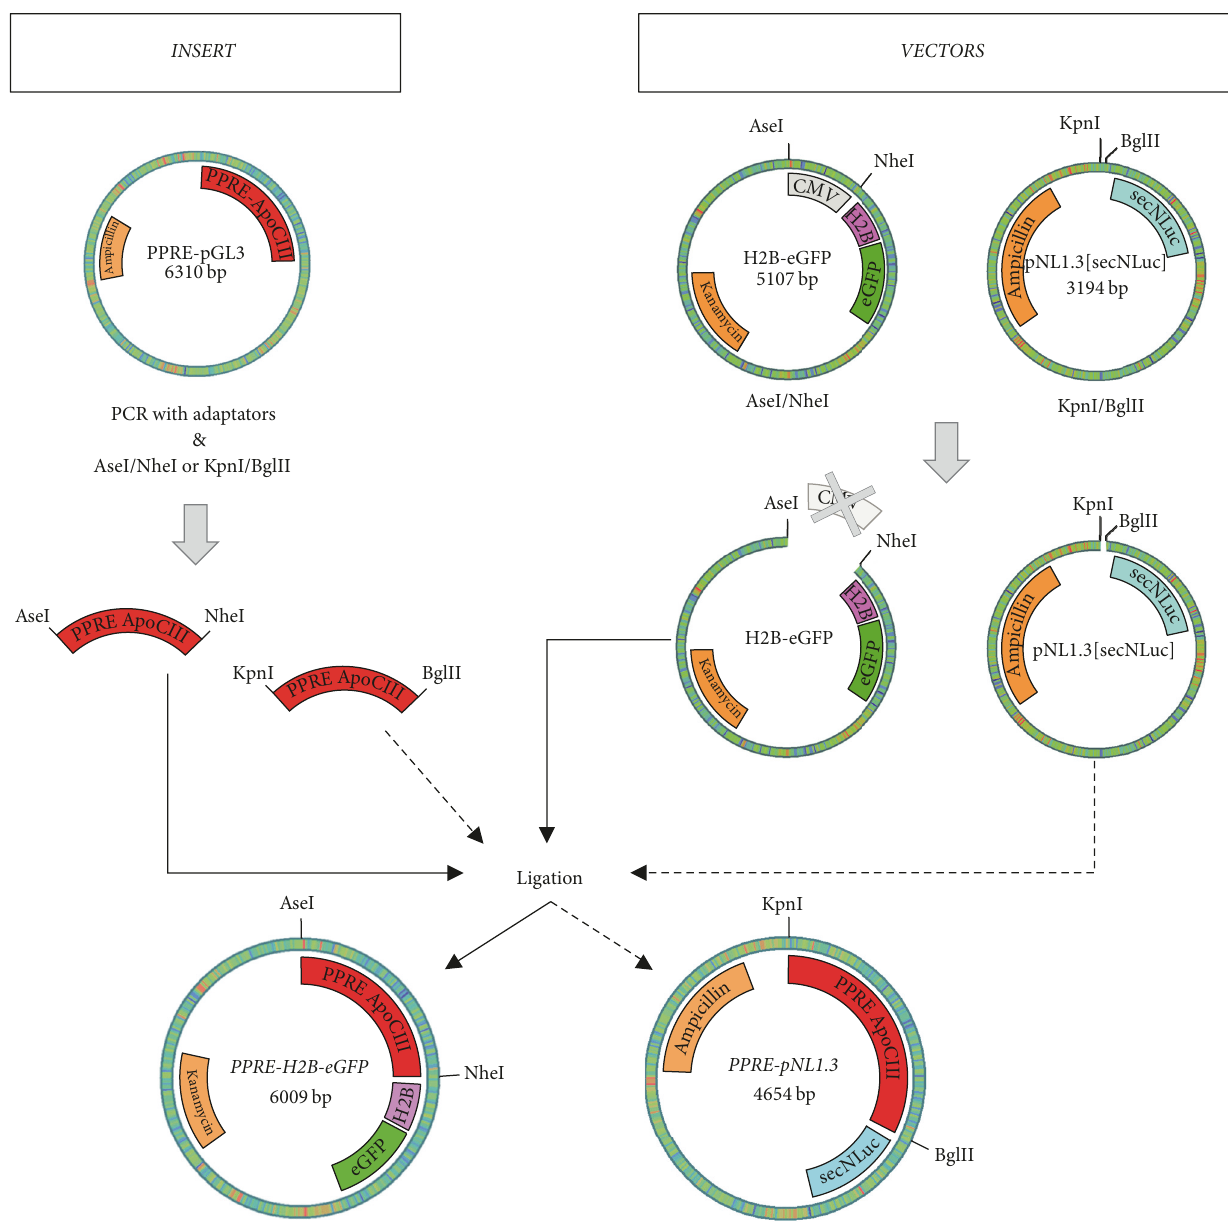
Figure 1: Schematic diagram of PPRE-H2B-eGFP and PPRE-pNL1.3 plasmid